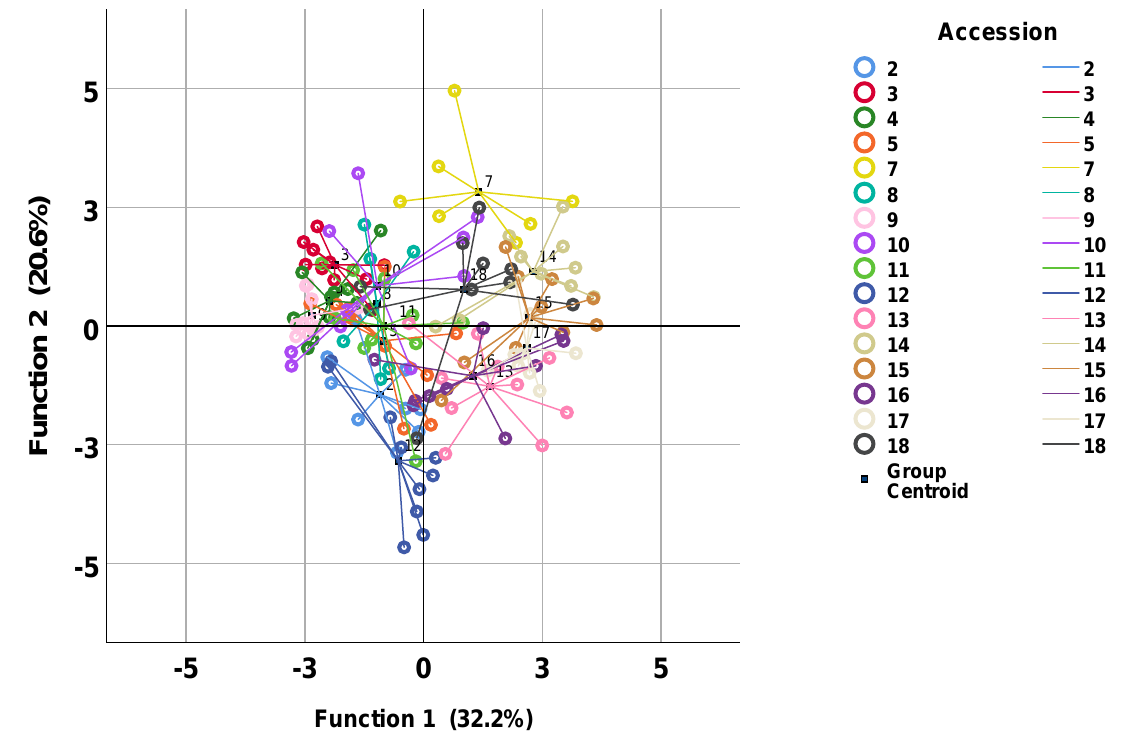
Figure 4. Discriminant scores of the two first functions grouping the samples to the